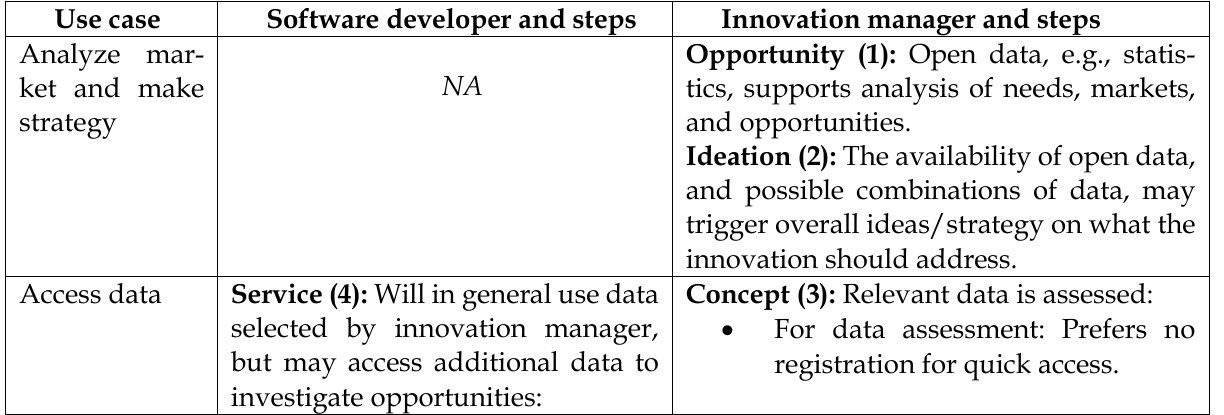
Table 3 Use cases and roles with inks to digital innovation process steps Use